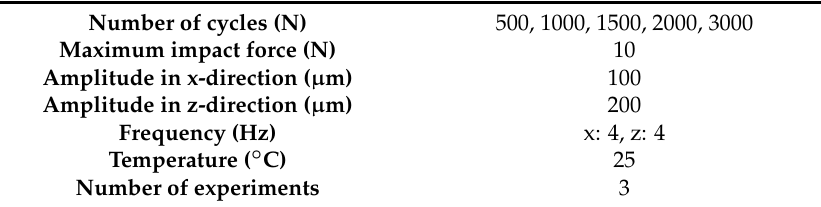
Table 1. Experimental conditions for the impact-sliding fretting wear